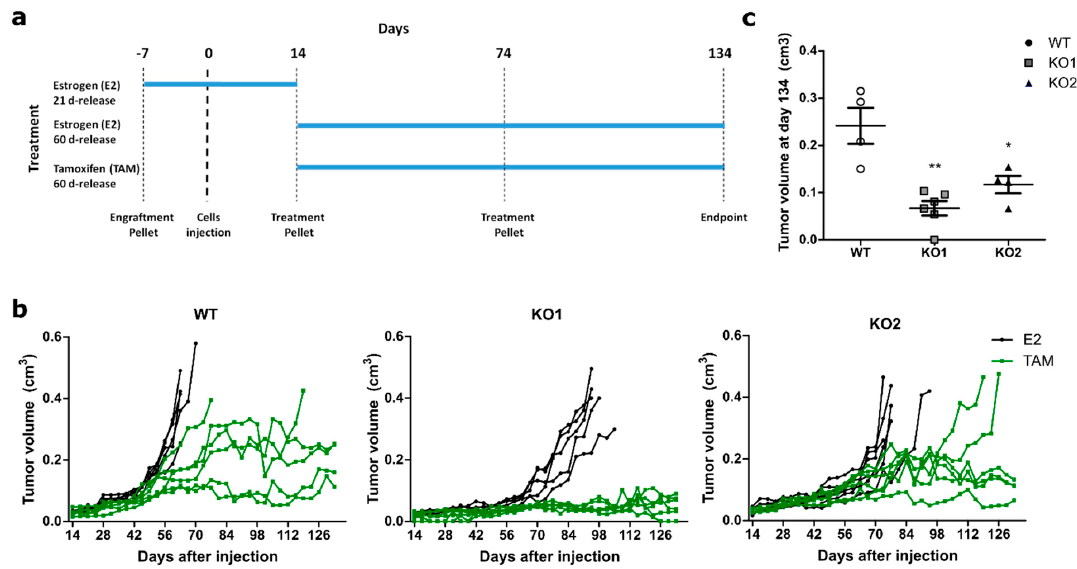
Figure 4. ATF3 knockout impairs in vivo tumor growth upon tamoxifen treatment. ( a ) Schematic representation of the animal experiment. ( b ) Tumor volume over time up to 120 days of treatment. Tumor growth curves are plotted for mice treated first with an E2 21-day-release pellet (0.25 mg)